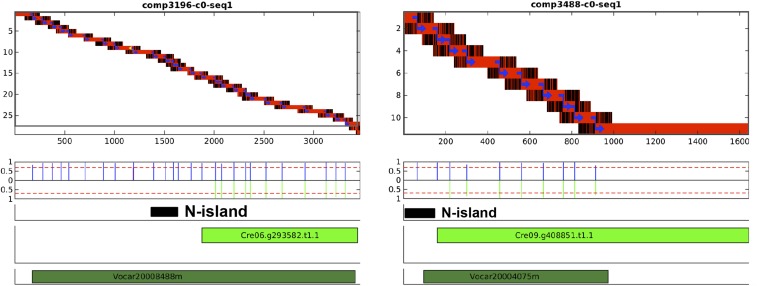
Flanking N islands can truncate a gene model. Diagrams as in Figure 5. Two Phytozome transcript models with flanking N islands are shown, Cre06.g293582.t1.1 and Cre09.g408851.t1.1 (light green bars). The Trinity objects comp2196_c0_seq1 and comp3488_c0_seq1, respectively, align to the body to the Phytozome transcripts, and extend into the N islands (represented by black bars). The Trinity sequence in the extensions (unaligned to Chlamydomonas sequence) can be aligned by Blastx to Volvox proteins (dark green bars).